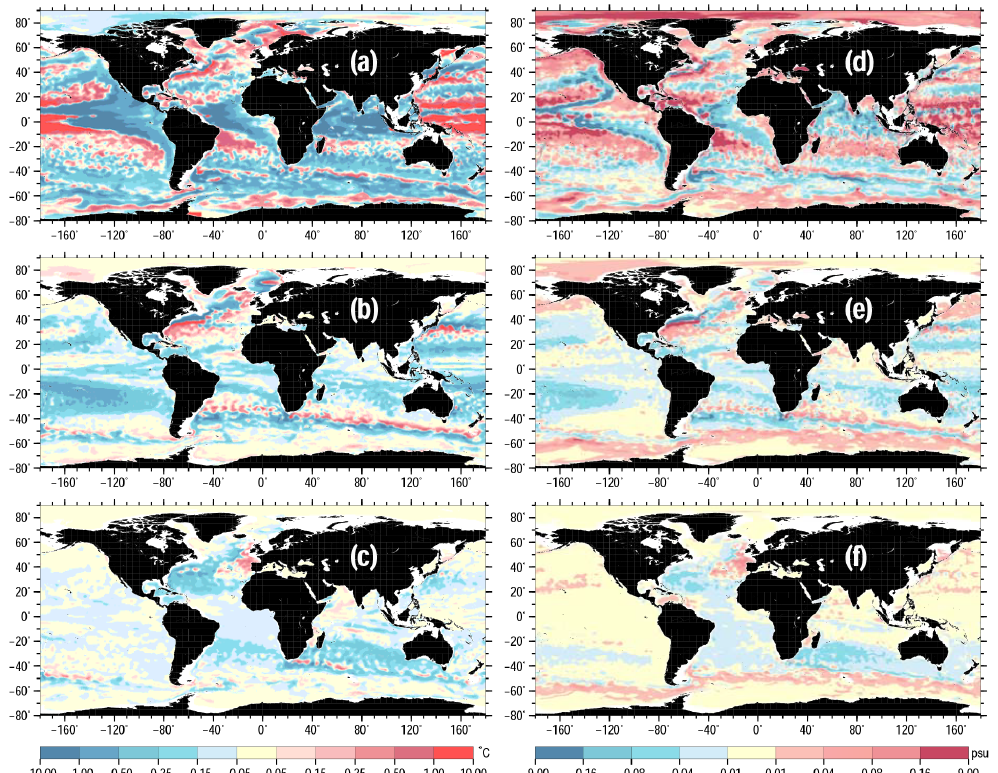
Figure 9. Temperature (a–c) and salinity (d–f) isopycnal WAGHC climatology minus WOA13 climatology differences for selected depth levels in January: 150m (a, d) , 518m (b, e) , and 1050m (c, f)